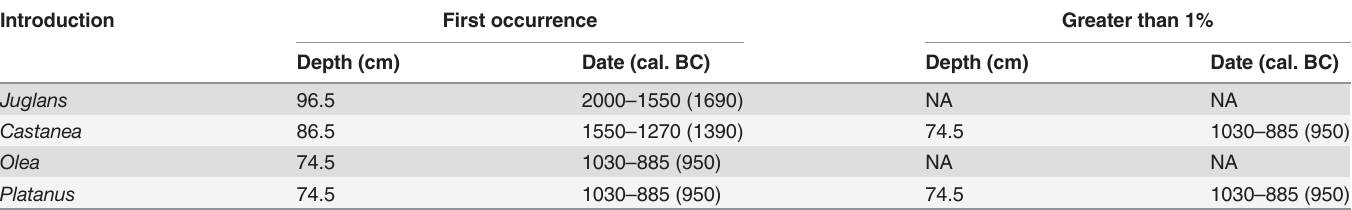
Table 5. The depths and dates for the first appearances of pollen from selected plant introductions in the palynological record from Corent. The median probable age from the age-depth model is presented in